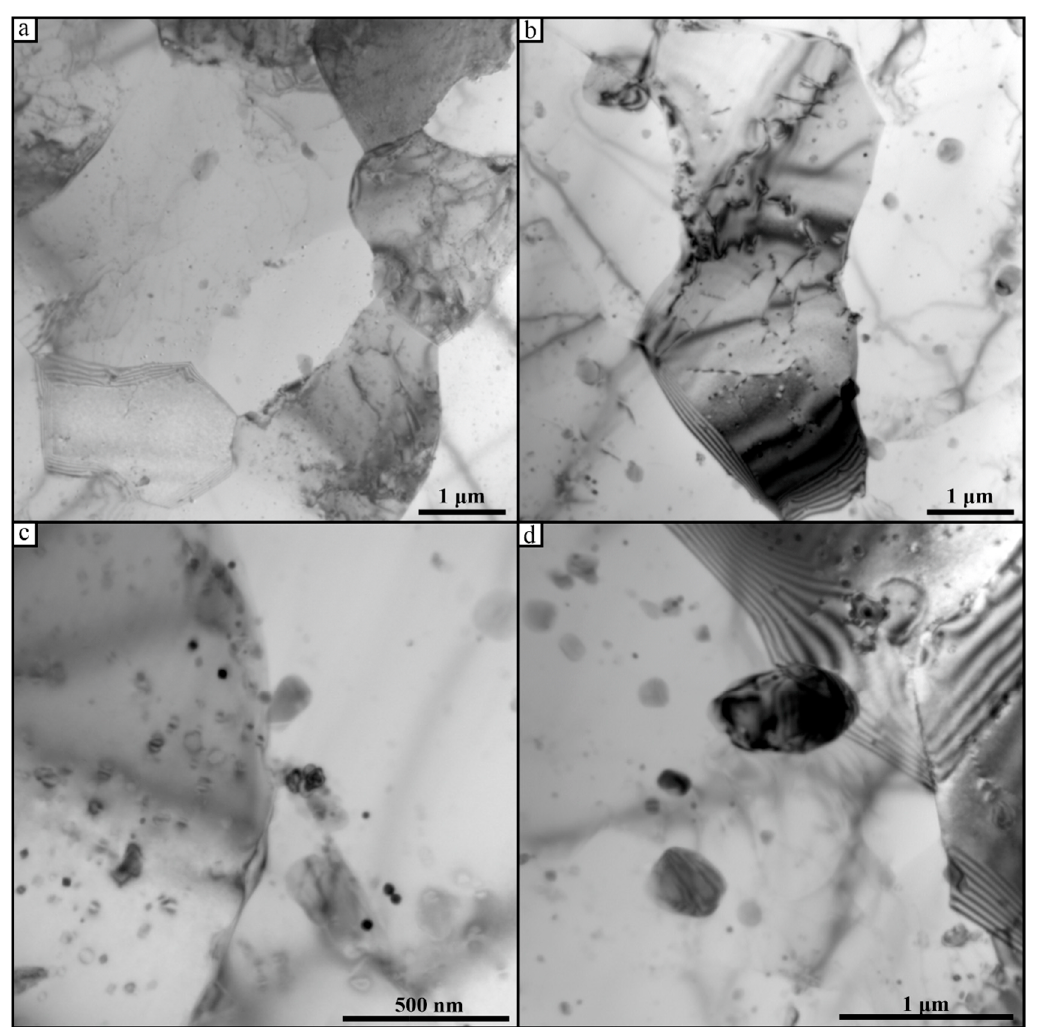
Figure 9. TEM images of the stir zone coarse precipitates, grains, and dislocation loops in 35 mm ( a , c ) and 30 mm ( b , d ) welds.